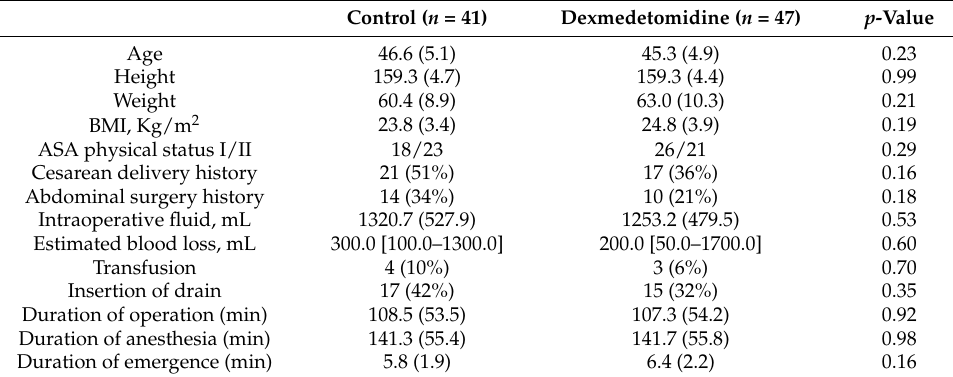
Table 1. Patient demographics and operative details.